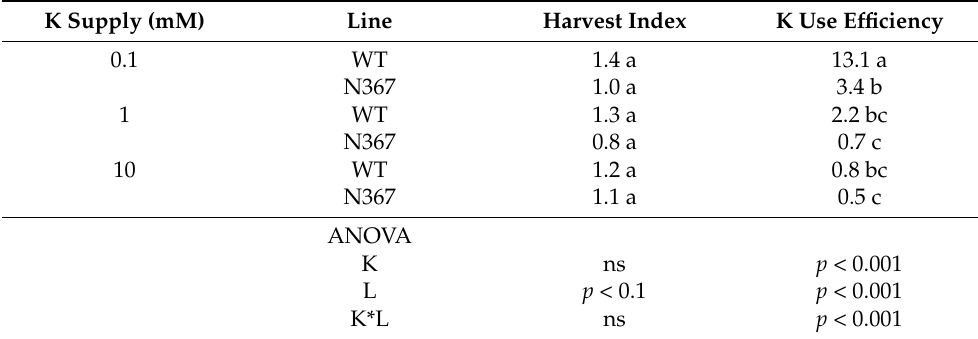
Table 4. Differences in harvest index and K use efficiency between two tomato lines (WT and N367) grown with different K availabilities and subjected to six cycles of drying/watering. In columns, means followed by the same letter are not significantly different (LSD Test, p < 0.05). K and L in ANOVA represent potassium and line factors, respectively. K Supply (mM)